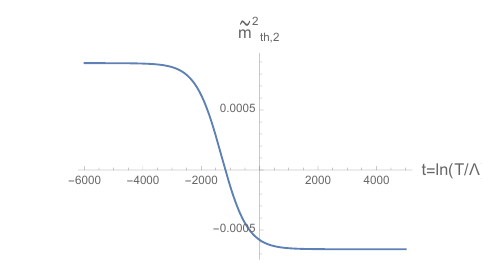
Figure 4. Plots of the rescaled thermal masses (squared) against t = ln( T/ Λ) for r = 0 . 1 , θ = π , λ = 0 . 001 , (cid:15) = 0 . 1 : in the low temperature regime, both e This indicates that the baryon symmetries in both the sectors are unbroken in this regime. In the high temperature limit, saturates at a positive value, while m 2 e th , 1 This means that the baryon symmetry in the second sector remains persistently broken above a critical temperature. This critical temperature ( T